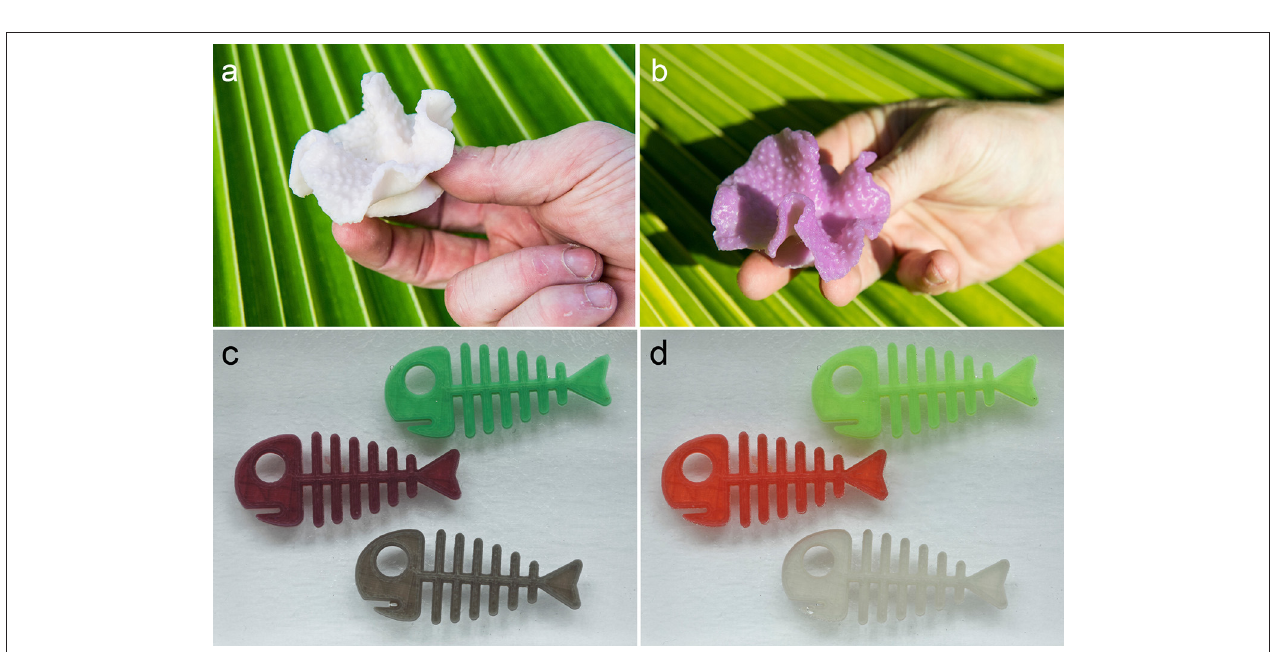
FIGURE 11 | Sensing materials for coral research. (a) Photochromic PLA 3D print of Turbinaria sp. skeleton. (b) Photochromic PLA 3D print of Turbinaria sp. skeleton under direct sunlight. (c) Thermochromic PLA 3D prints below 23 ◦ C. (d) Thermochromic PLA 3D prints above 23 ◦